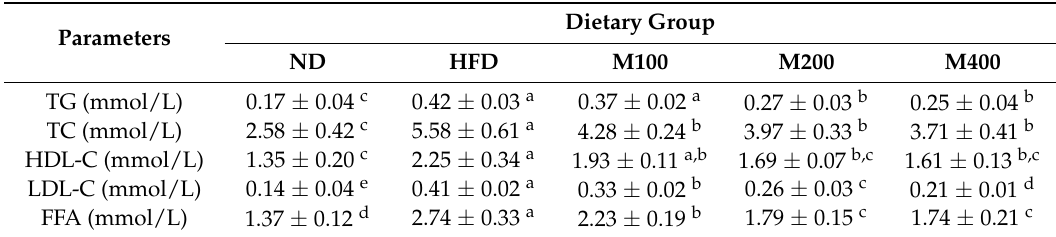
Table 2. Effect of MFGM on serum lipid profile in HFD-fed